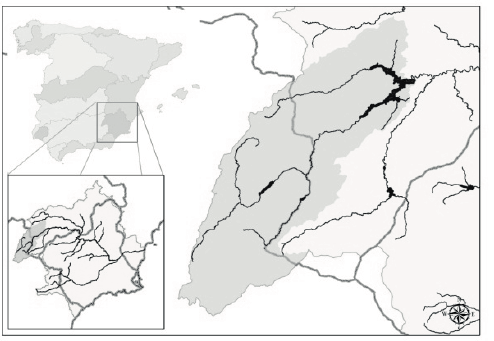
Fig. 1 Location of Segura River basin in the Iberian Peninsula, and detail of Fuensanta basin.